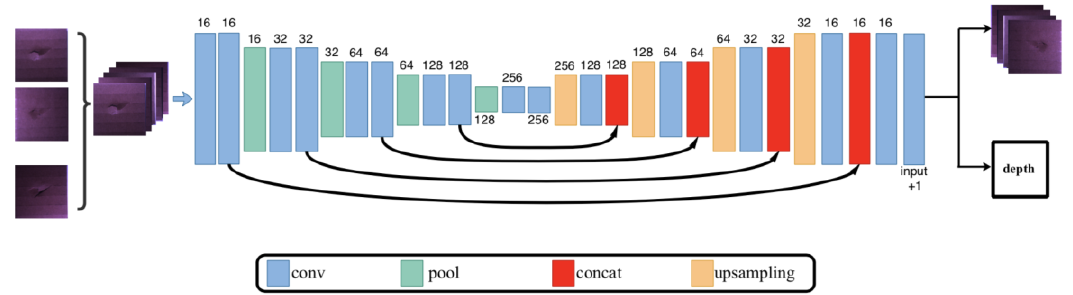
Figure 1. Overview of the proposed network architecture. The network outputted a depth map when given a set of images from the light source direction with di ff erent angles as inputs. The kernel sizes for all the convolutional layers were 3 × 3 and for all up-sampling layers 2 × 2. Values above the layers indicate the number of feature